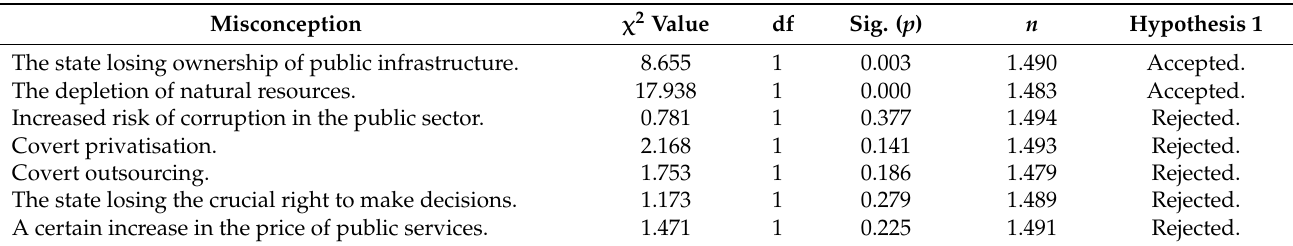
Table 2. Chi-square test results for all misconceptions.